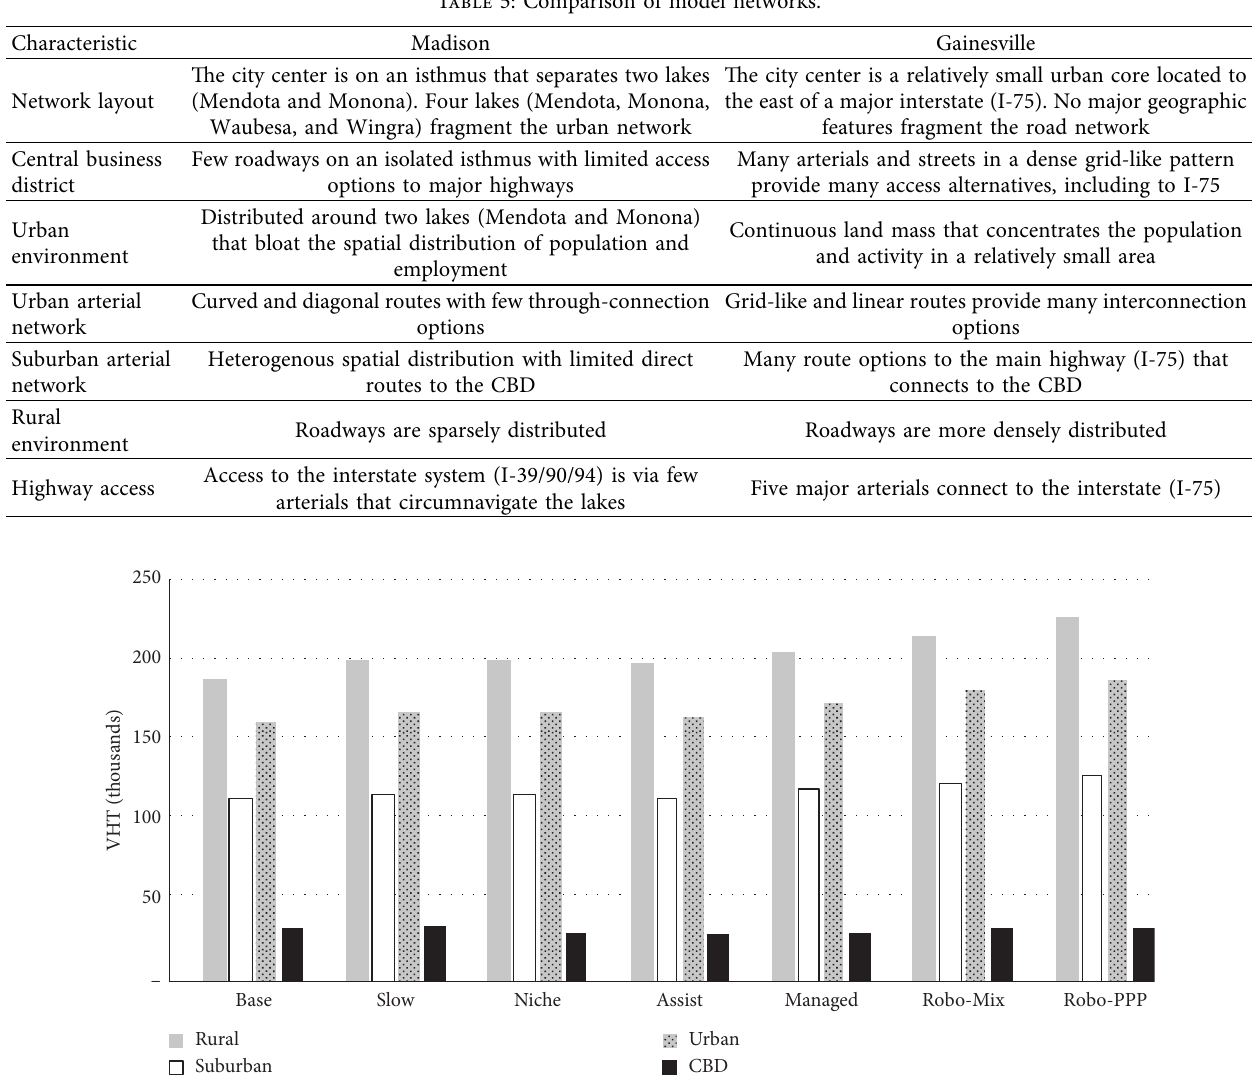
Figure 4: Madison 2050 VHT by area and